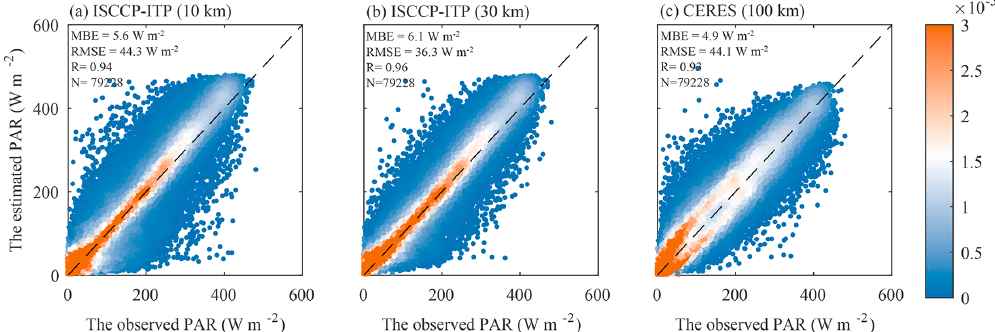
Figure 2. Comparisons of our estimated instantaneous PAR product (ISCCP-ITP) at spatial resolutions of (a) 10km, (b) 30km, and (c) hourly PAR of the CERES SYN1deg (edition 4.1) with observed PAR collected at seven SURFRAD stations.